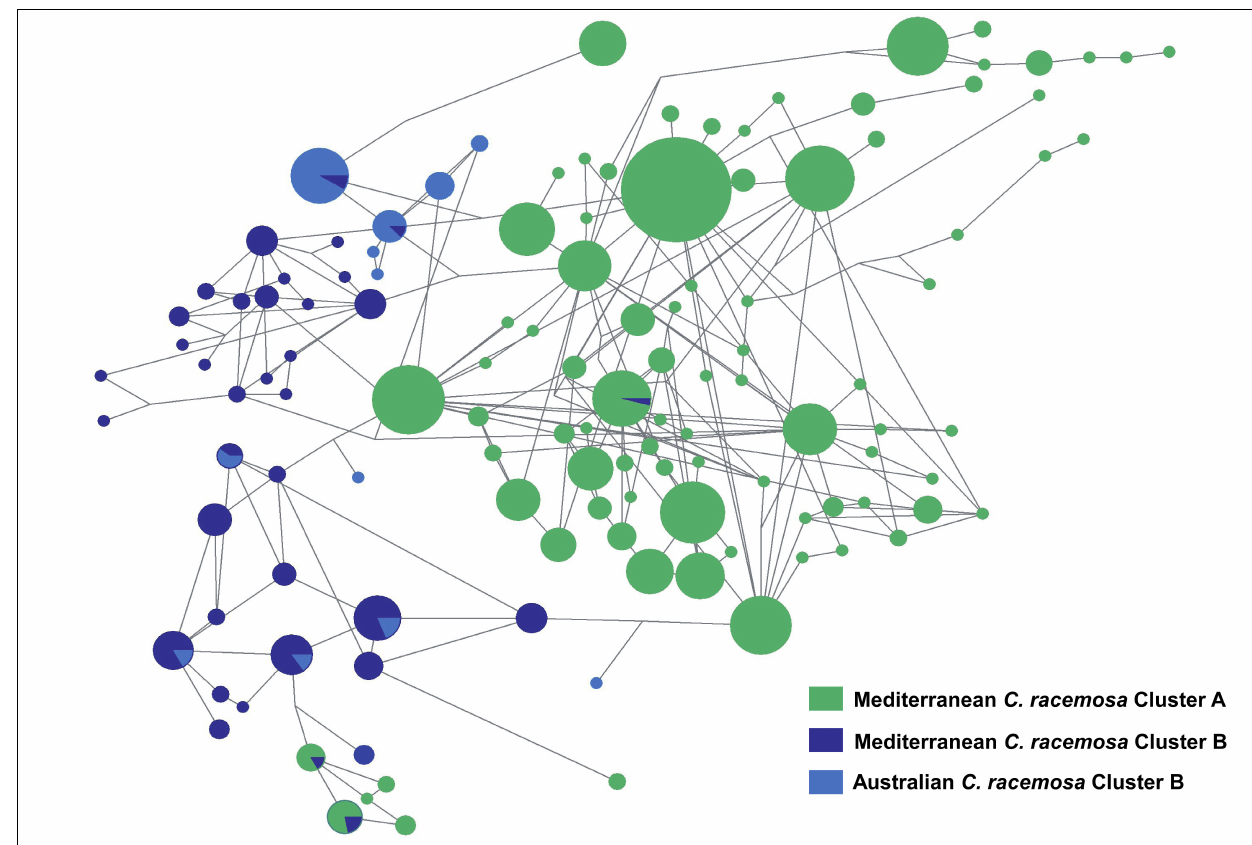
Figure 5. Network of haplotypes from the most ubiquitous OTU (110) in the set of OTUs represented in Comamonadaceae family phylogenetic tree. Network was drawn without keeping distance of links proportional to the number of mutations, in order to illustrate the clustering rather than the divergence doi: